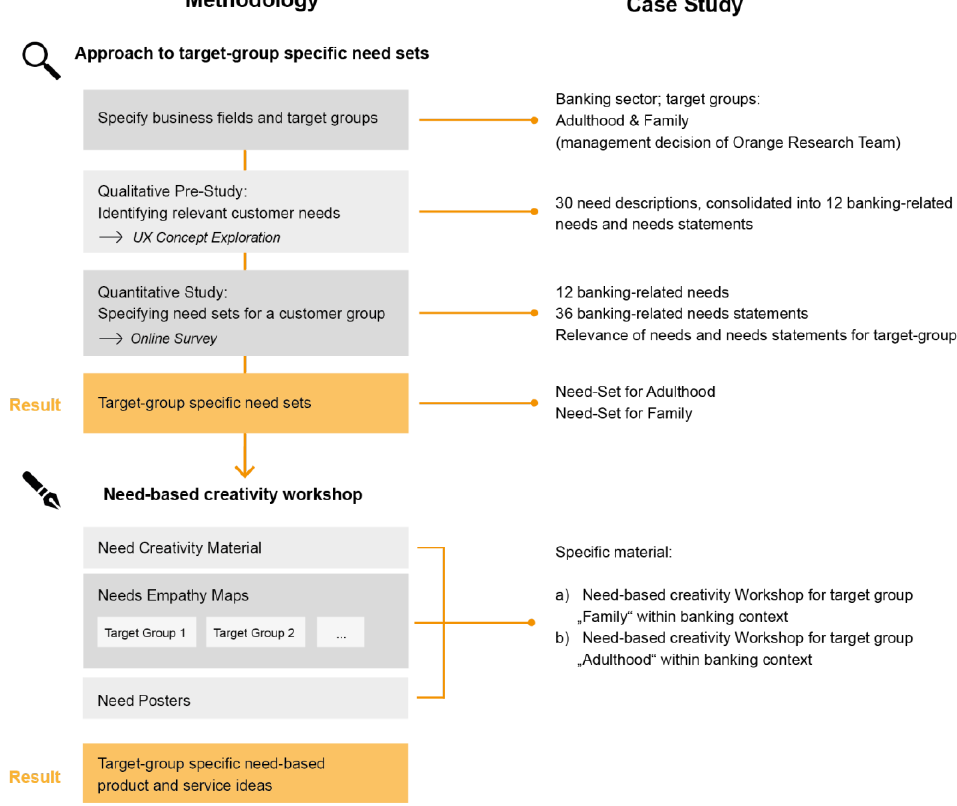
Figure 2. Overview of the methodological approach ( left ) and related outcomes of the case study ( right ): our approach consists of different steps in order to gather knowledge about the needs of a specific target group in a specific business context. These results will then fuel a creativity workshop to generate new product and service ideas.